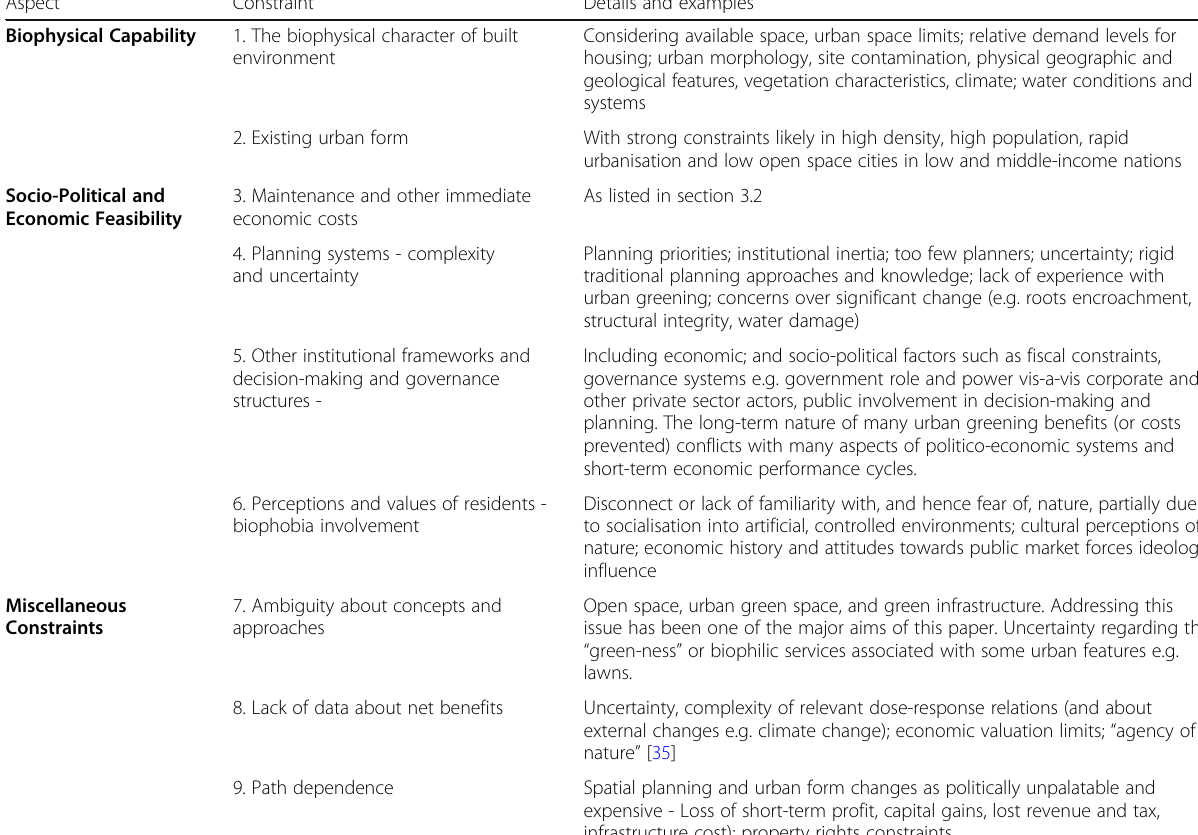
Table 4 Key constraints to implementation Aspect